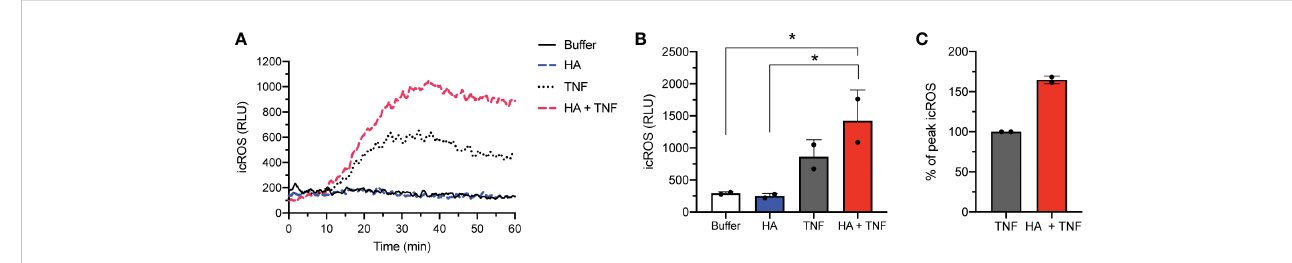
FIGURE 4 Intracellular ROS release in co-stimulated neutrophils. (A) Intracellular ROS production (y-axis, relative light units (RLU)) by neutrophils over time (x-axis, min) after stimulation without (buffer) and with TNF a (10 ng/mL), HA (200 m g/ml), or HA with TNF a . Histogram is representative of 2 independent experiments. (B) Bar graphs show mean peak intracellular ROS (icROS, y-axis, RLU) + SD for unstimulated (buffer) or HA-, TNF a − , and HA+TNF a - stimulated cells (x-axis). (C) Peak icROS (mean + SD) in co-stimulated (HA + TNF a ) neutrophils is presented as % of peak icROS relative to the